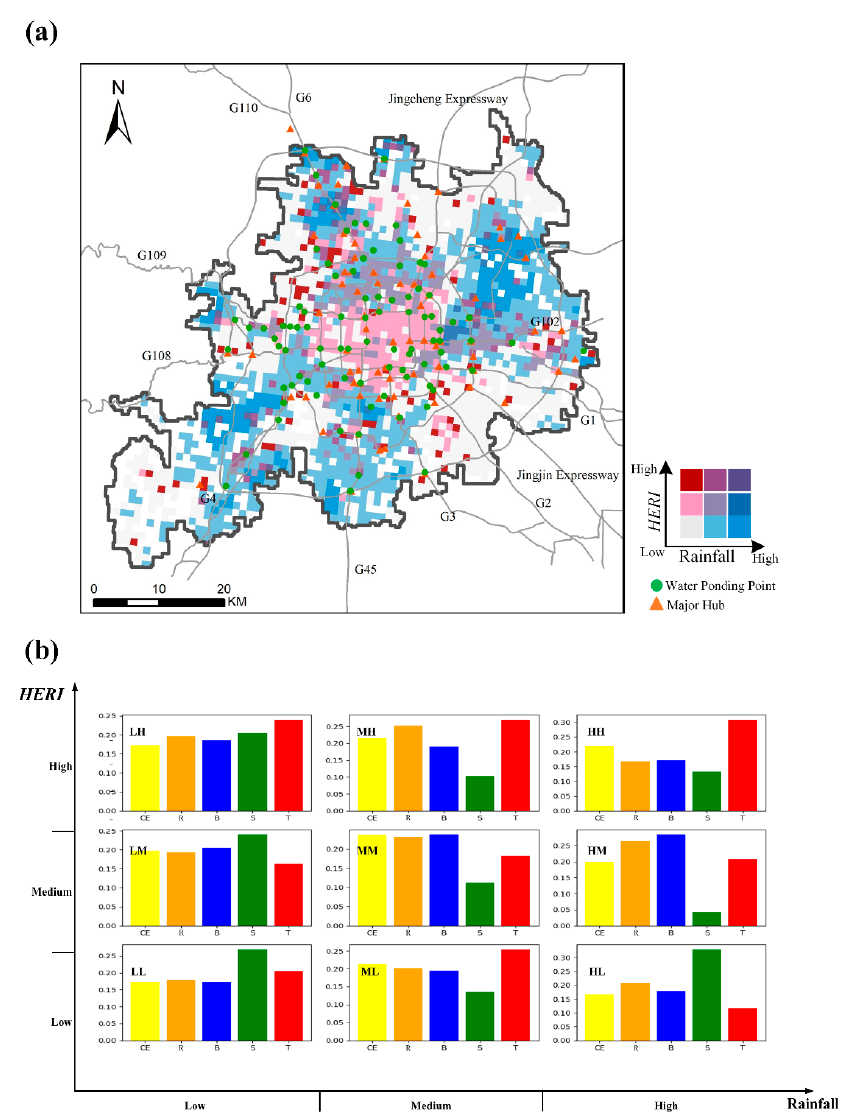
Figure 13. The ENRR values across our study area ( a ) and the proportions of different types of POIs within the areas with different ENRR values ( b ).